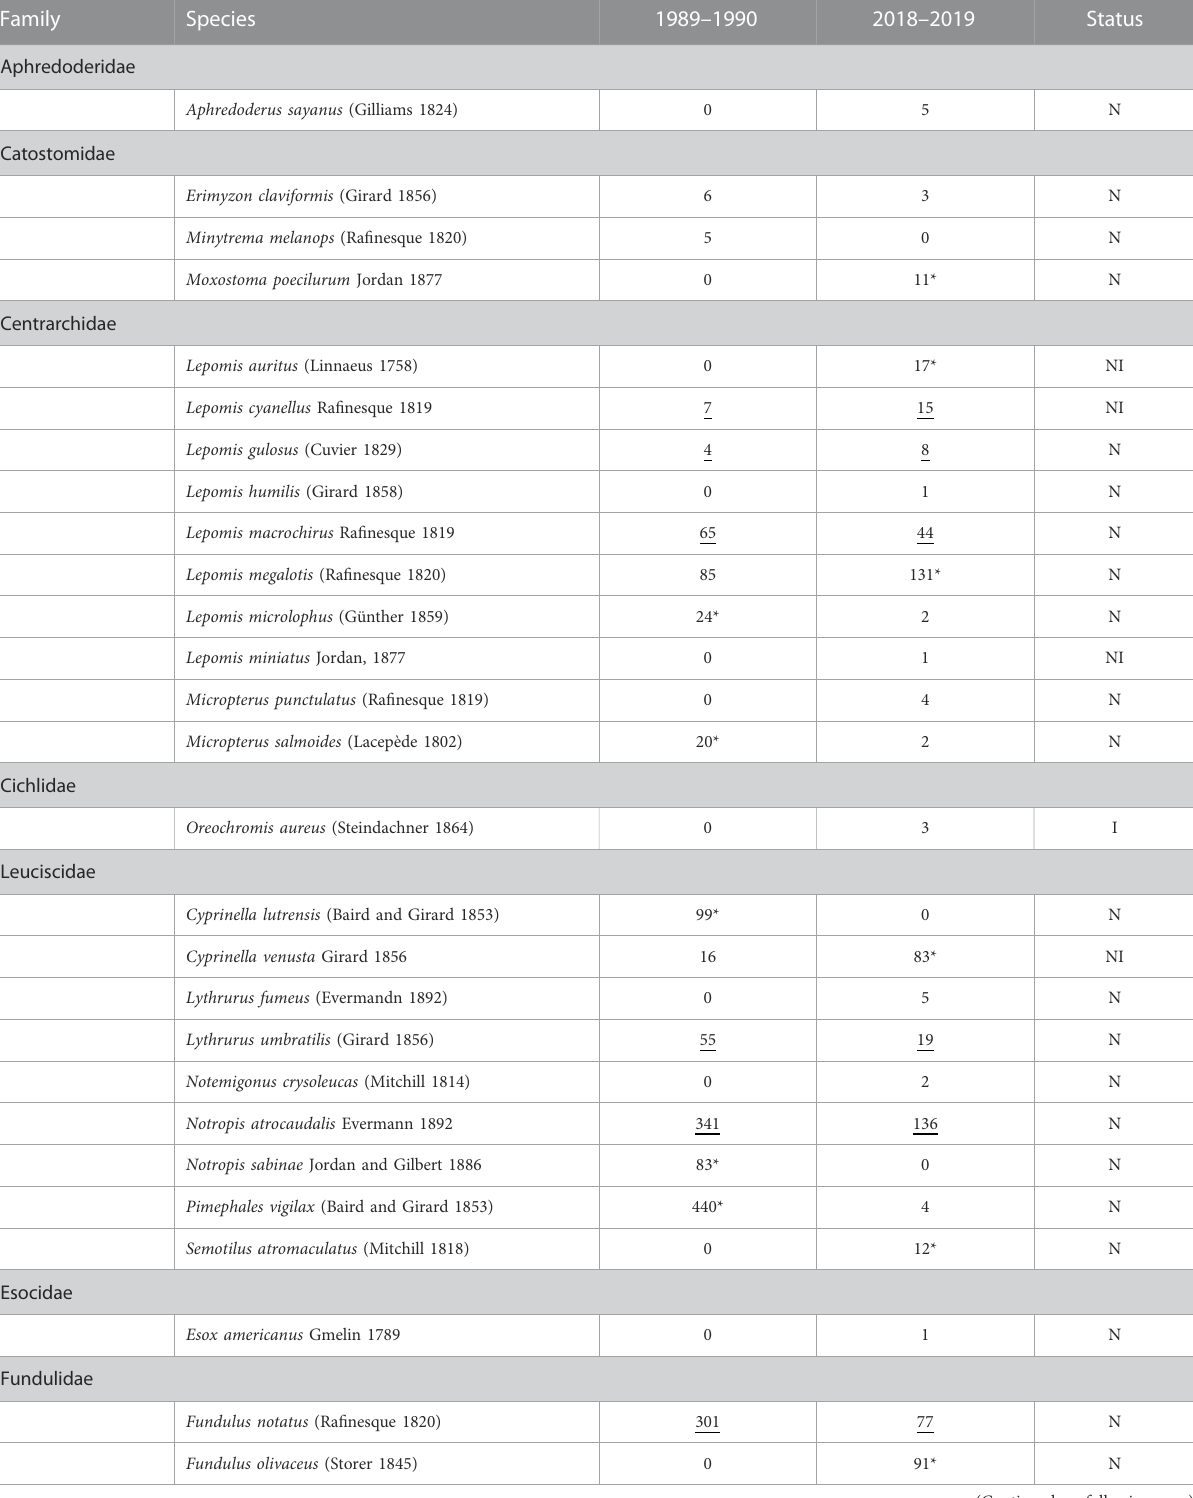
TABLE 1 Occurrence of fi sh species in the 1989 – 1990 and 2018 – 2019 surveys. Asterisks (*) refer to time “ Restricted to ” species of 1989 – 1990 and 2018 – 2019 surveys. Underlined ( − ) values refer to “ Consistent ” species over the two surveys according to CLAM analysis classi fi cation. “ N ” refers to native species, “ I ” refers to introduced species, and “ NI ” to native invader species from the United States, but introduced in the La Nana Creek basin, Nacogdoches Texas, United States.